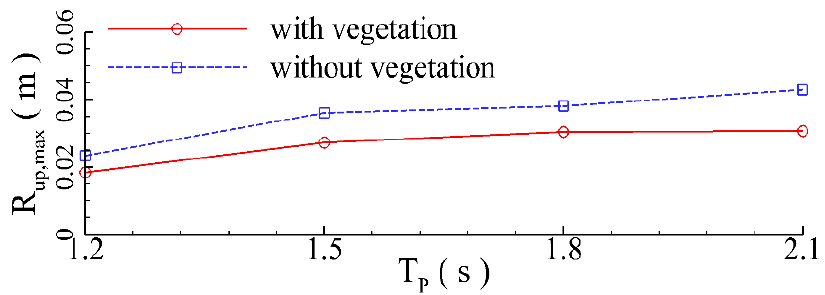
Figure 23. Dissipation rate of the wave energy under peak wave periods.